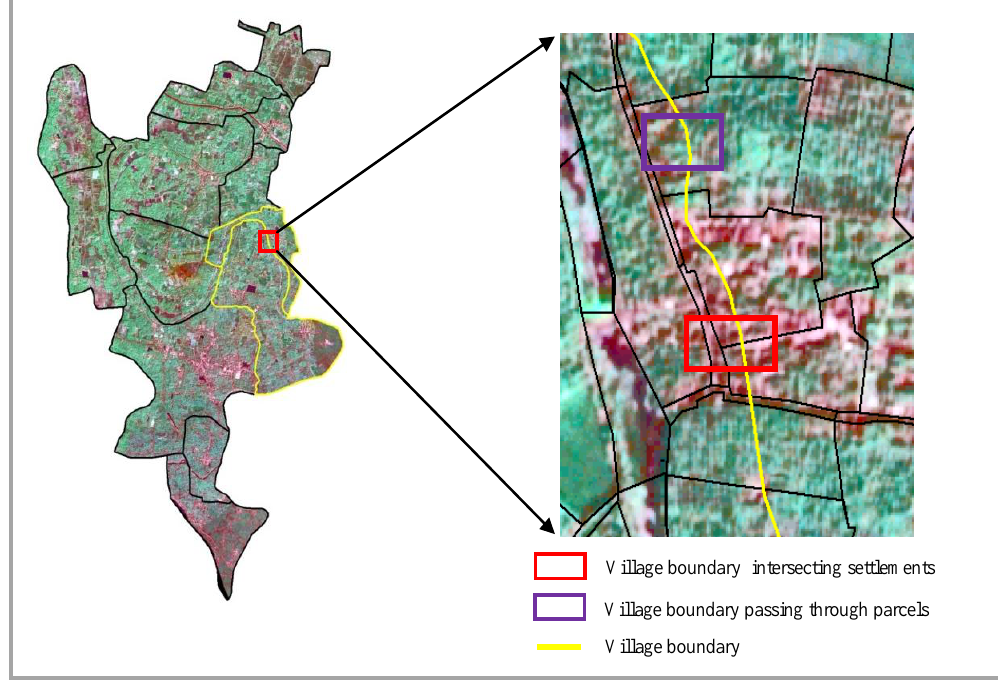
Figure 11: Village boundary 2011 overlaid on